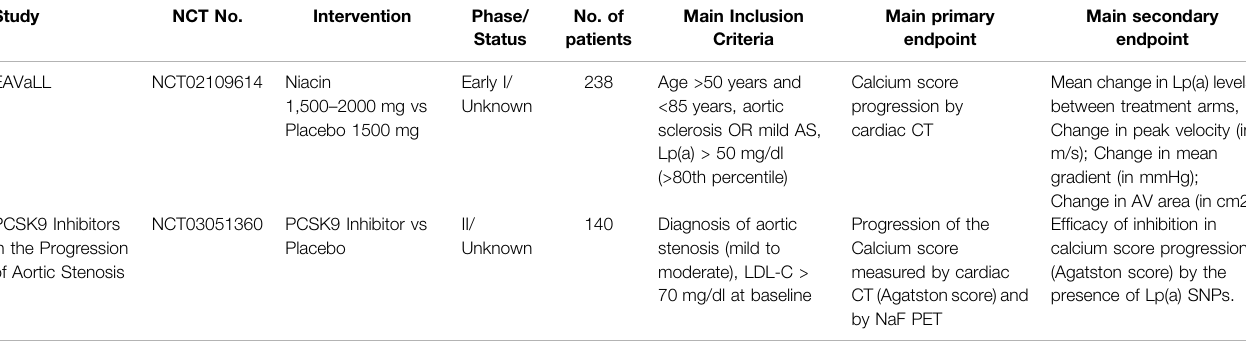
Age > 50 years and < 85 years, aortic sclerosis OR mild AS, Lp(a) > 50 mg/dl ( > 80th percentile) 140 Diagnosis of aortic stenosis (mild to moderate), LDL-C > 70 mg/dl at baseline